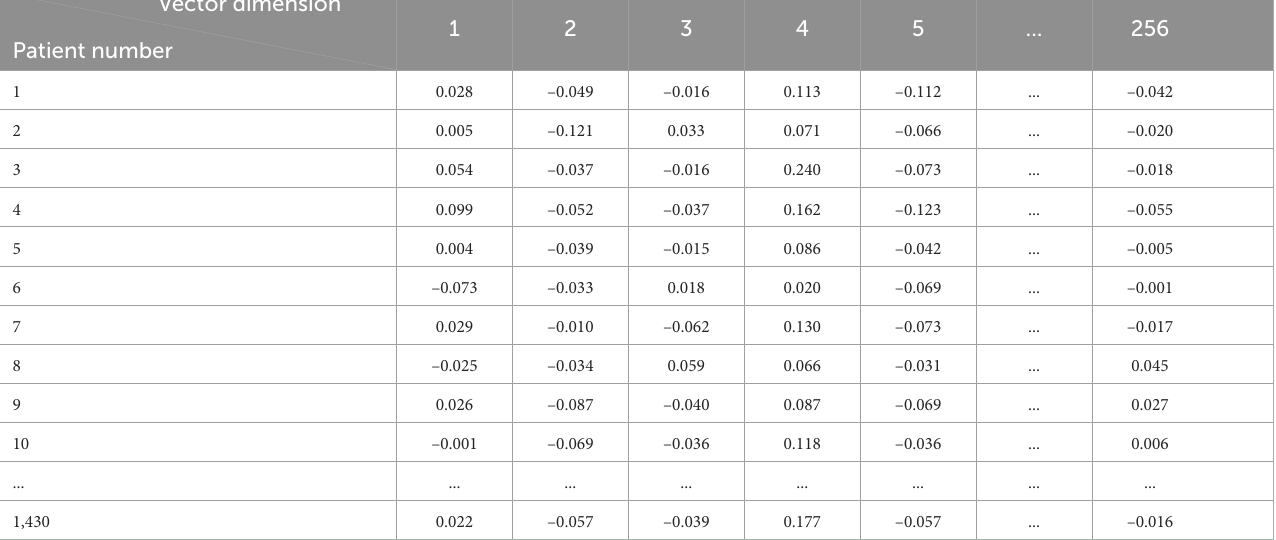
TABLE 6 The vector representation of the patient’s main complaint text.